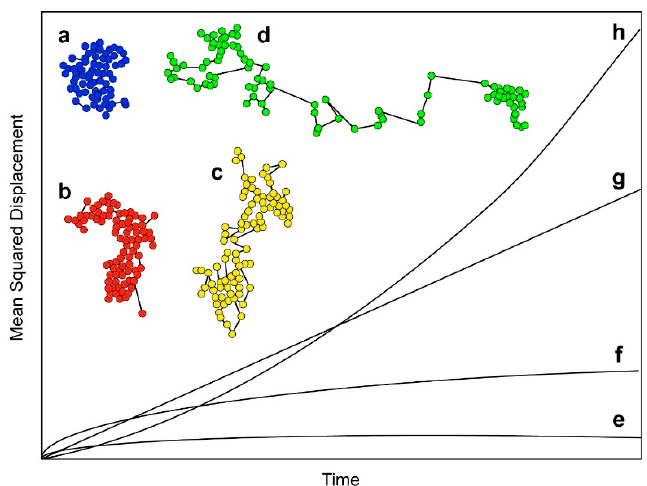
Figure 1. Types of receptor motion measurable by single-particle tracking (SPT) (adapted from Bacher et al., 2004 [45]): ( a ) Confined molecule; ( b ) Restricted motion; ( c ) Simple diffusion mode; and ( d ) Directed motion. ( e – f ) show mean squared displacement (MSD) plots that would be obtained for the types of motion shown in ( a – d ), respectively.